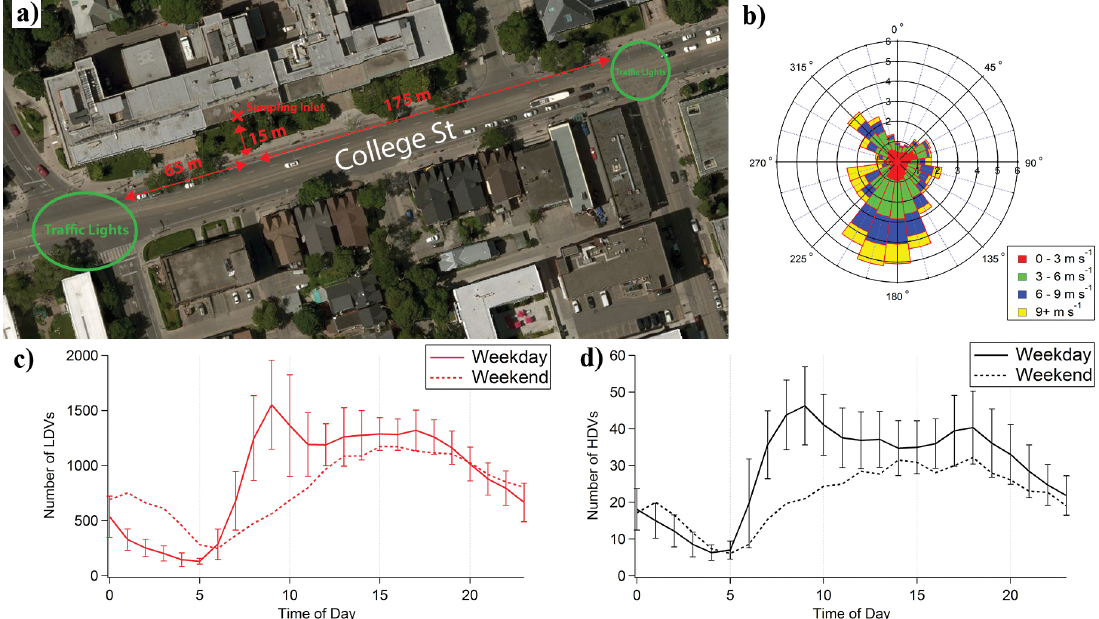
Figure 1. Aerial view of measurement site including distances between sampling inlet, roadway, and nearby traffic lights (a) ; wind rose plot from measurements over all four campaigns (b) ; diurnal trends of number of light-duty vehicles (LDVs) (c) and heavy-duty vehicles (HDVs) (d) with error bars indicating standard deviation. Satellite and aerial imagery is courtesy of Bing Maps. Table 1. Summary of measurement site instrumentation and the corresponding sensitivity, range, precision and time resolution. Parameter Instrument type Model Effective Range sensitivity (precision) a